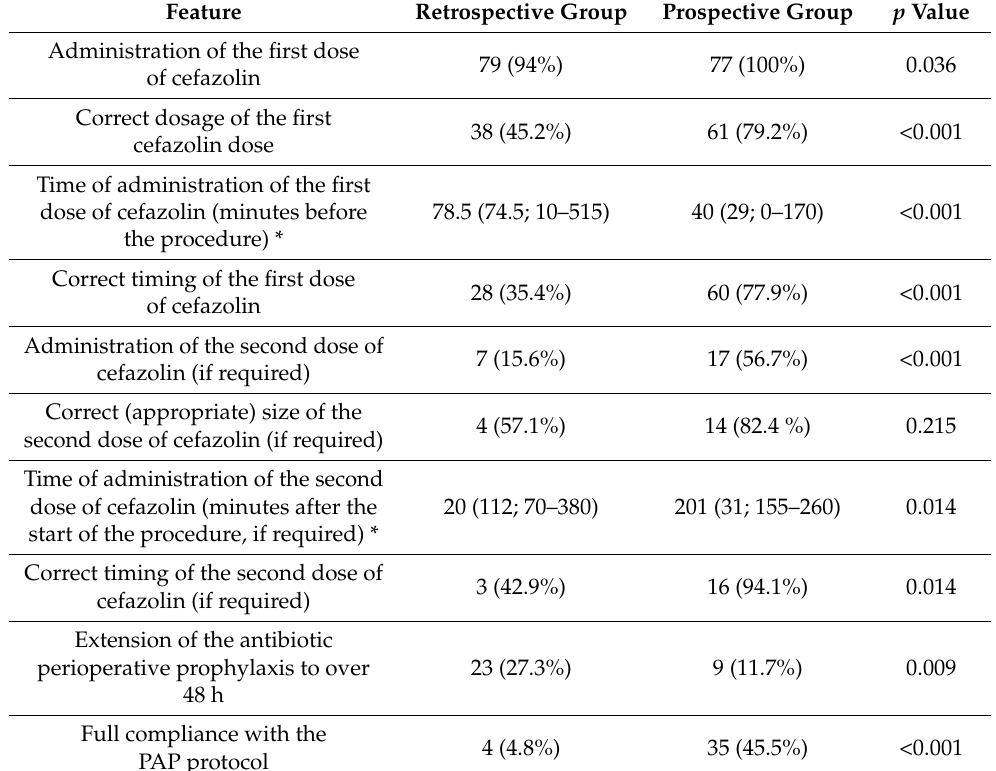
Table 3. Assessment of preoperative and intraoperative compliance with the PAP